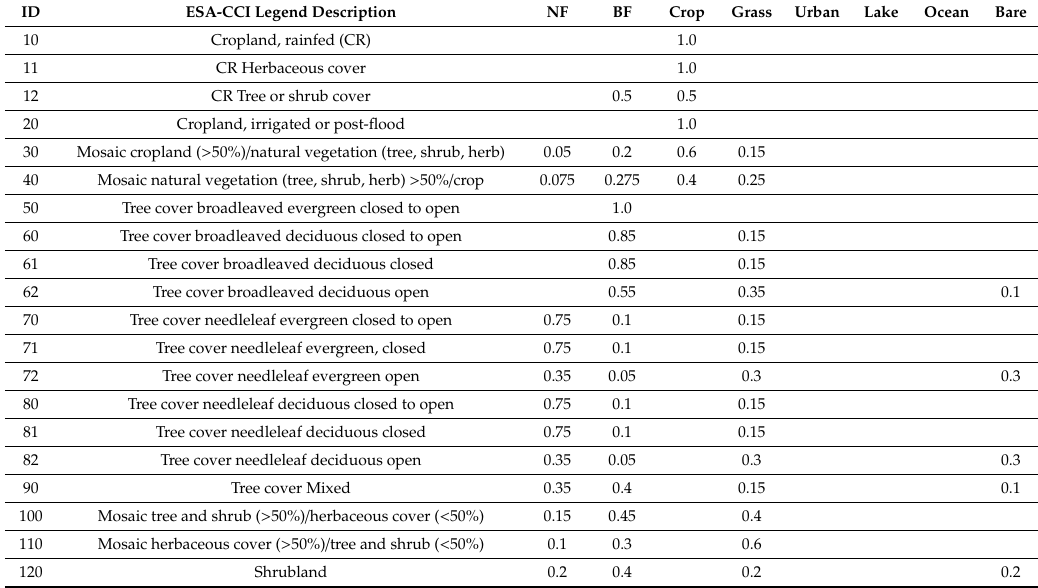
Table 4. Cross-walking table for converting CCI LC classes into CLASS